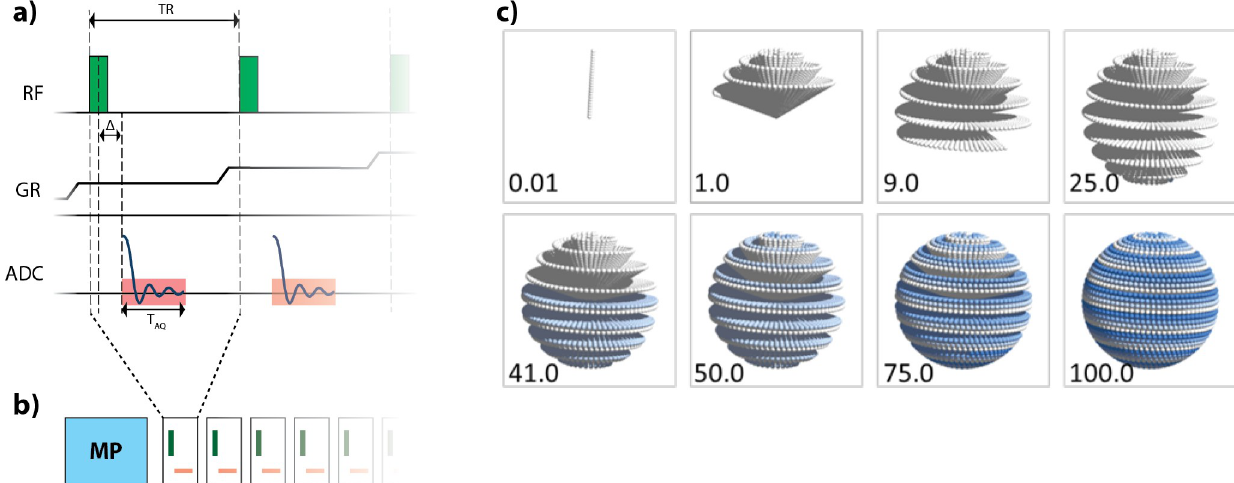
Fig 1. Magnetization-prepared ZTE scheme. (a) The basic ZTE acquisition sequence. After a non-selective excitation pulse, applied in the presence of the read-out gradient (GR), sampling takes place after a system specific dead time Δ , to switch from the transmit to the receive state. (b) After appropriate Mz magnetization preparation (MP) a number of ZTE profiles are measured in a train spiraling further along the given trajectory path. Note, as illustrated schematically in (a), that the read-out gradient is on all the time, changing only slightly its direction from shot to shot. (c) Shows the temporal order of the individual ZTE spokes in the 3D radial k-space. The numbers indicate the scanned k-space percentage.